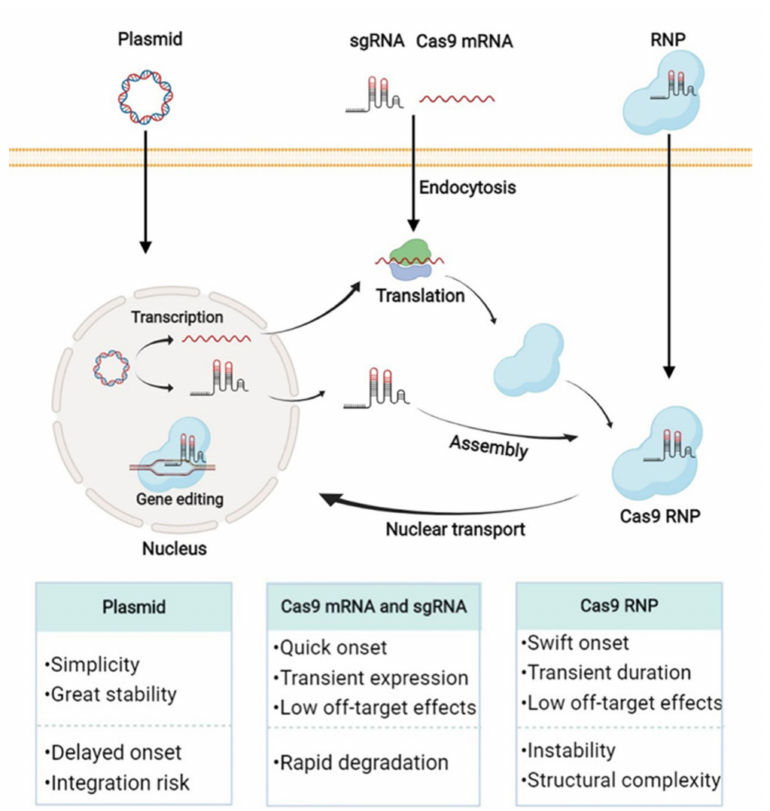
Figure 2. Representative genome editing routes and features of CRISPR-Cas9 in the form of DNA, RNA, and RNP (Created with BioRender.com, accessed on 29 September